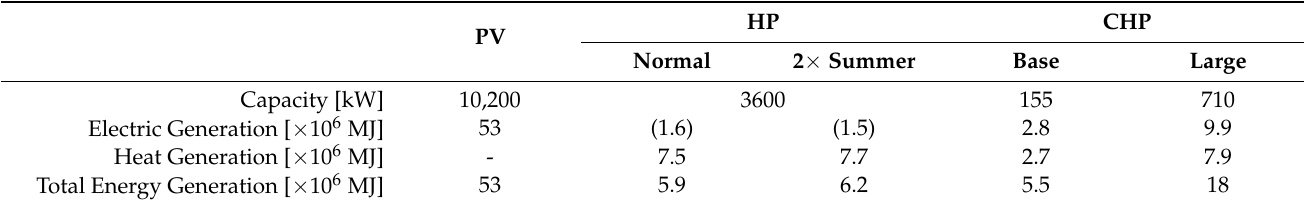
Table 1. NWC annual energy-generation capacity. Capacities are listed by renewable energy type and technology. Heat Pump (HP) is reported as a parenthesized negative electric generation, meaning that electric load increases, and a positive heat generation, meaning natural gas load is reduced. Thus, the total energy generation reported in the table is the energy load reduction compared to a non-HP